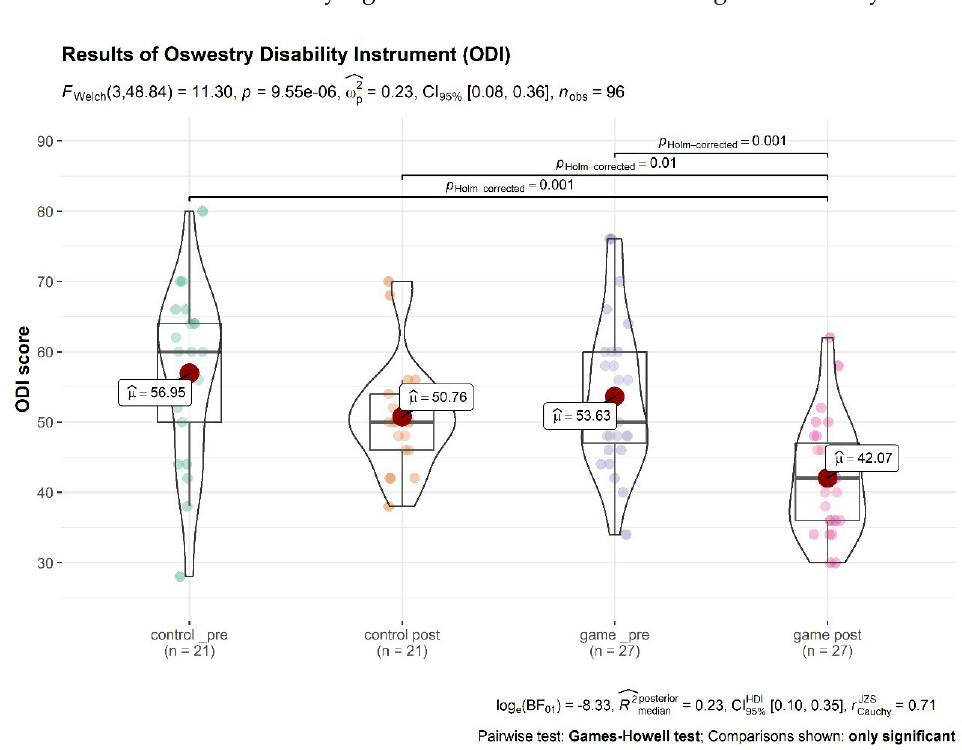
Figure 8. Results of Oswestry Disability Questionnaire